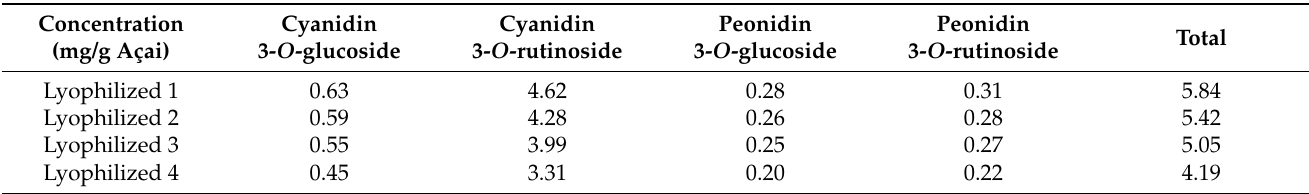
Table 5. Individual anthocyanin concentrations (mg/g) in real samples. Lyophilized 1: used for the method optimization; Lyophilized 2: acquired from Mundo Arcoiris; Lyophilized 3 and 4: acquired from a local supermarket in Cadiz,